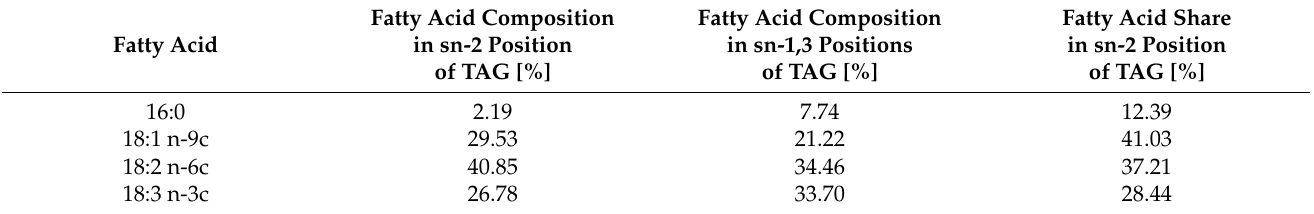
Table 2. Fatty acid composition in sn-2 and sn-1,3 positions of TAG and the share of fatty acids in internal position (sn-2) of TAG in cranberry seed oil.